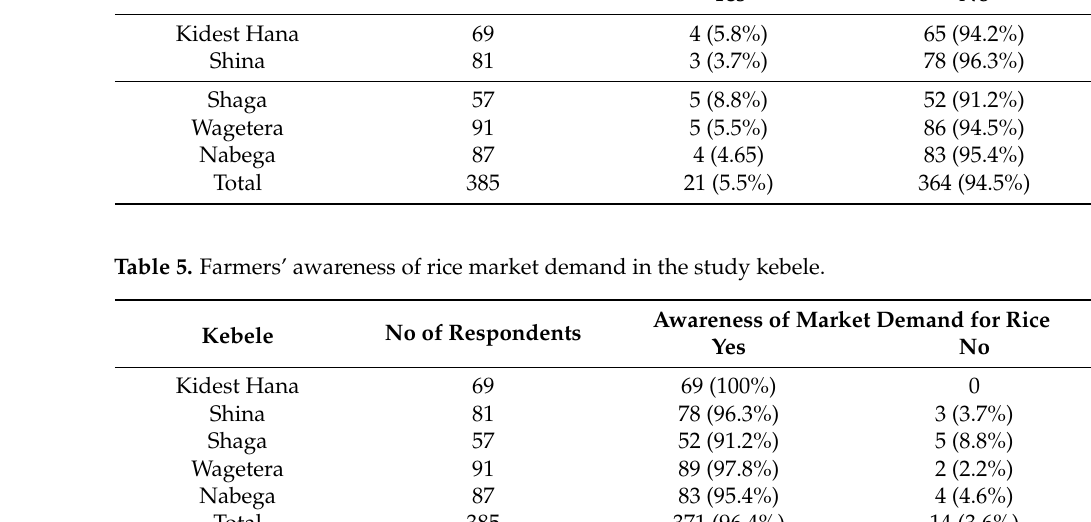
Enough Supply of Rice for Market Yes